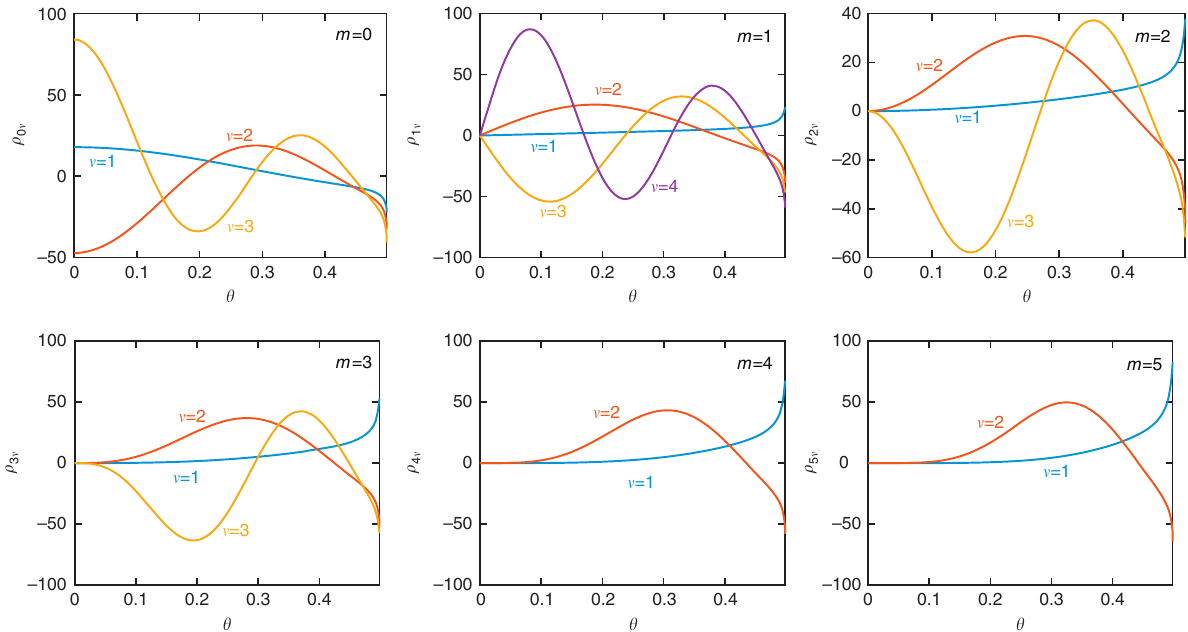
Fig. 5 Radial components of the disk PWFs. We show ρ m ν ( θ ) as de fi ned in Eq. (16a) and Eq. (16b) for several low values of m and ν (see also Table